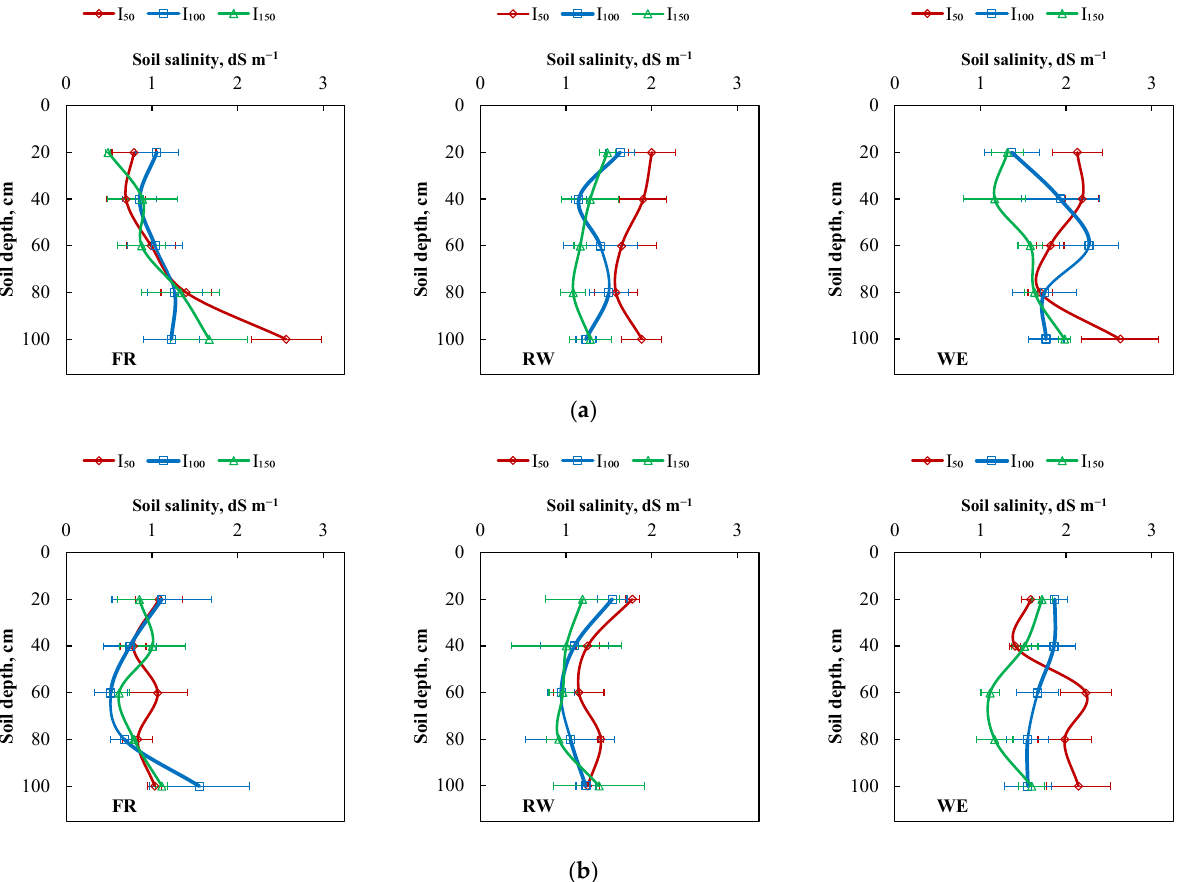
Figure 4. Soil salinity profiles from the fields watered using three irrigation levels (I 50 , I 100 , and I 150 : 50%, 100%, and 150% crop evapotranspiration, respectively) with three water types (FR: freshwater, RW: reclaimed wastewater, and WE: well water) measured at three dates in ( a ) 2017 and ( b ) 2018. Bars represent mean values ± standard error of triplicate